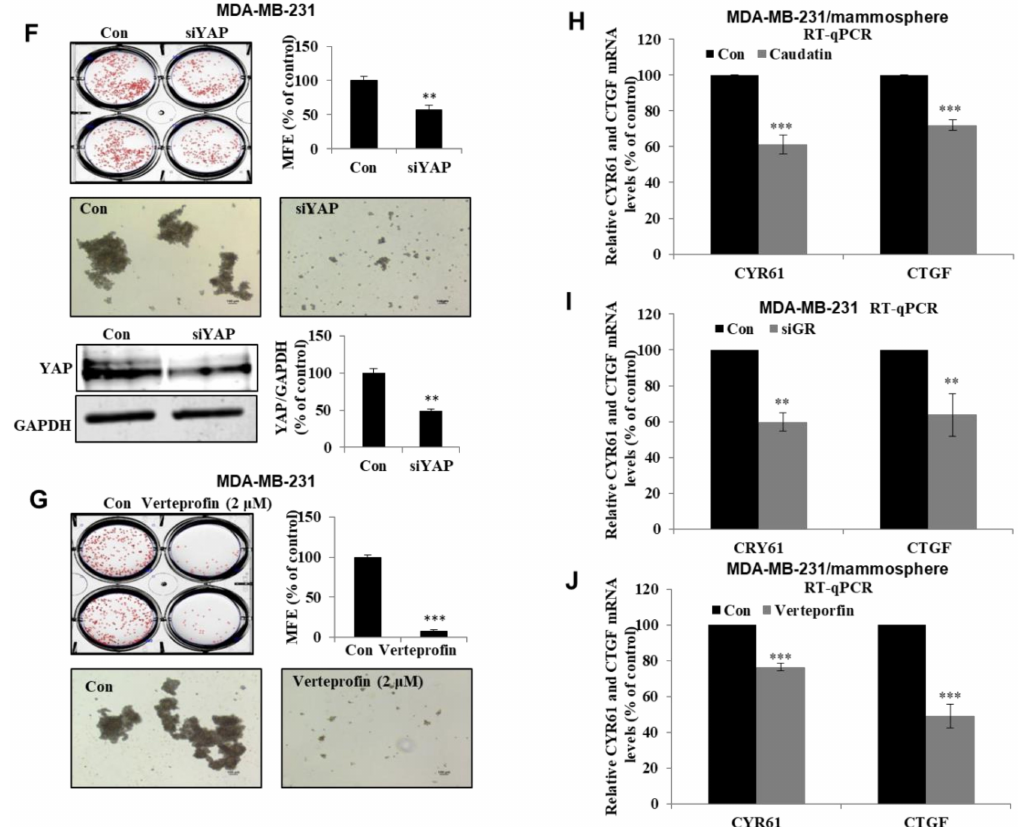
Figure 7. Caudatin reduces YAP nuclear localization and regulates breast CSC formation. ( A ) The expression level of YAP in the total protein of MDA-MB-231-derived mammospheres was measured after treatment of the mammospheres with caudatin for 48 h using western blot analysis. ( B ) The transcriptional expression of the YAP gene was detected in mammospheres by real-time RT-qPCR using specific primers. β -actin was used as an internal control. ( C ) Immunofluorescence (IF) analysis of YAP (red) expression and localization in MDA-MB-231 cells under caudatin treatment was performed. ( D ) The expression level of YAP in the cytosolic and nuclear protein fractions of MDA-MB-231-derived mammospheres was measured after treatment of the mammospheres with caudatin using western blot analysis. ( E ) The expression levels of GR and YAP in MDA-MB-231 cells were measured after treatment with a siRNA specific for GR. ( F ) The e ff ect of knocking down YAP expression using YAP-specific siRNA on mammosphere formation was evaluated. ( G ) The e ff ect of verteporfin, a suppressor of the YAP / TEAD complex, on mammosphere formation was evaluated. ( H – J ) After treatment with caudatin, siRNA targeting GR or verteporfin, the transcriptional expression of the CYR61 and CTGF genes was detected by real-time RT-qPCR using specific primers. β -actin was used as an internal control. The data are presented as the mean ± SD of three independent experiments. ** p < 0.01 and *** p < 0.001 versus the DMSO-treated control